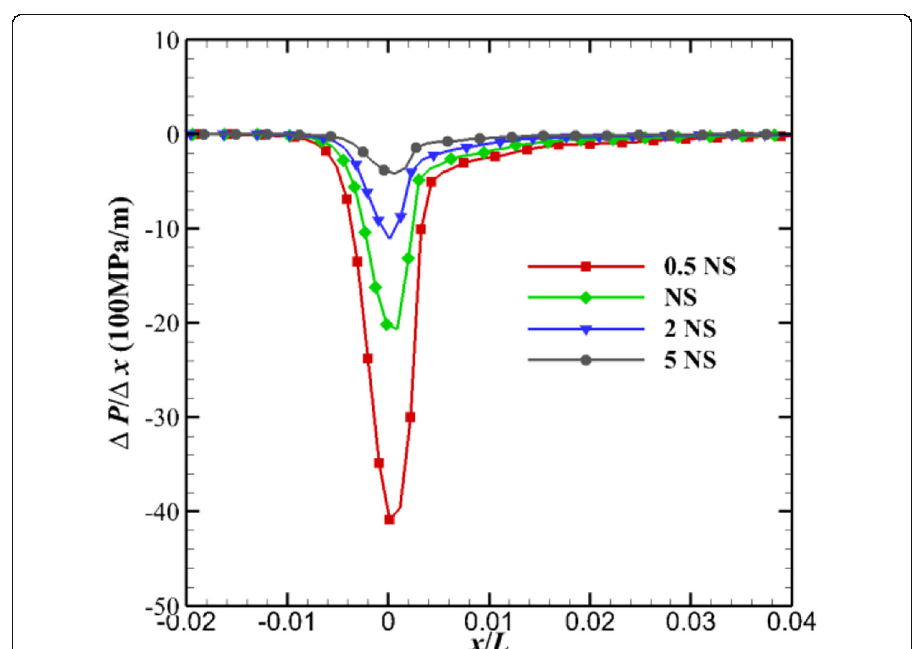
Fig. 7 Comparison of the centerline pressure gradient distribution based on the HEG nozzle